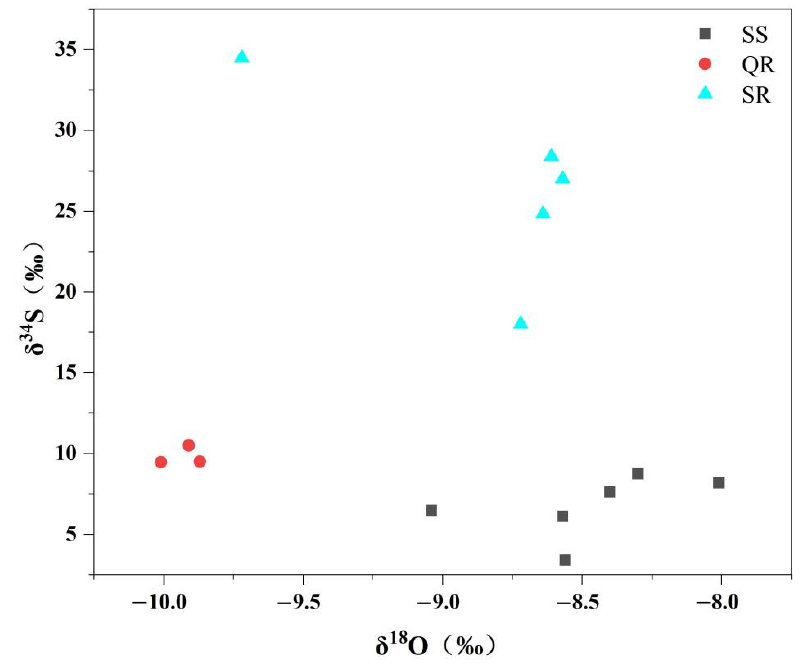
Figure 7. Comparison of S to O isotopic values in the geothermal fluid. Table 2. Mineral saturation